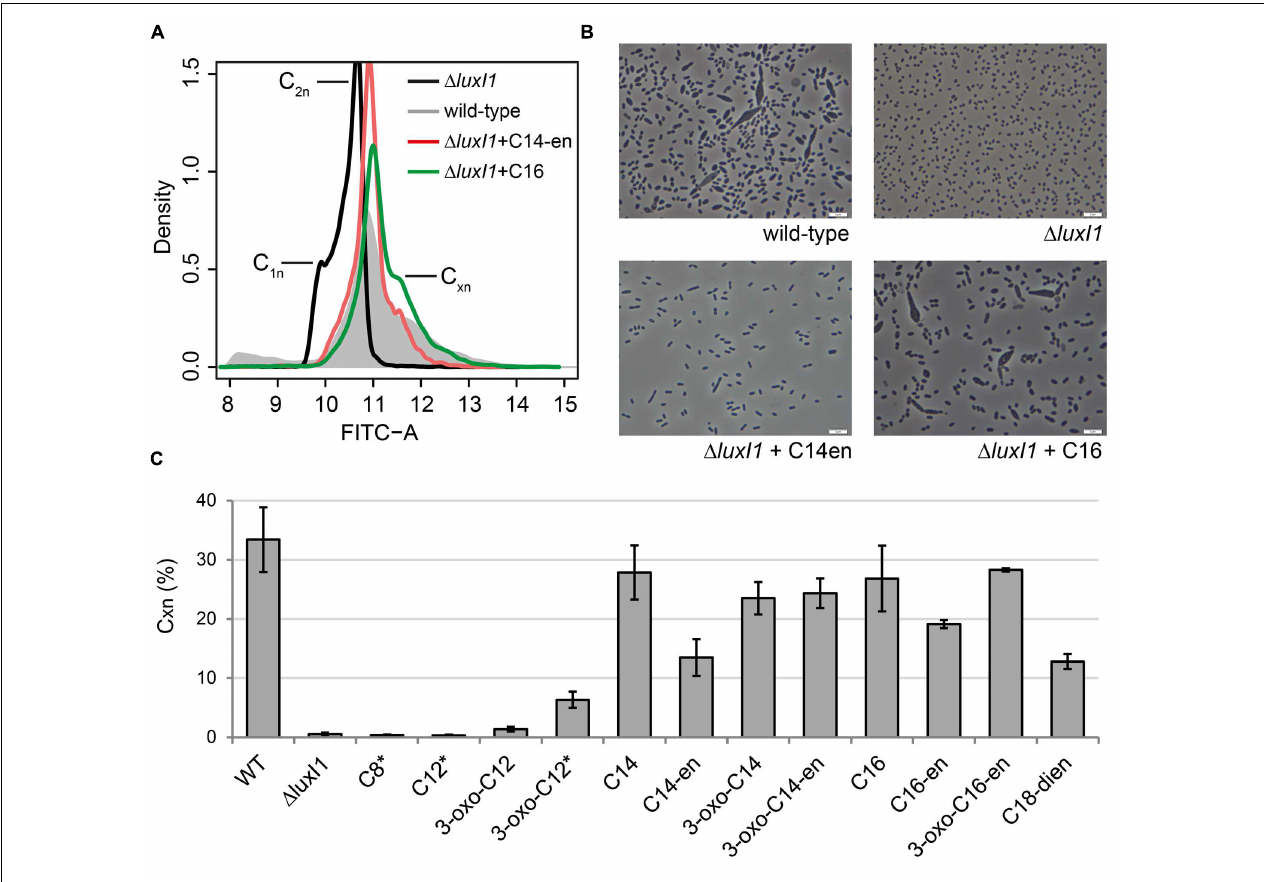
FIGURE 4 | Flow cytometric and microscopic analysis of the QS null mutant D. shibae (cid:49) luxI 1 cultivated with externally added AHLs. (A) Distribution of chromosome equivalents in the wild-type culture (gray), (cid:49) luxI 1 (black), (cid:49) luxI 1 provided with C14en (red), and (cid:49) luxI 1 provided with C16-HSL (green). (B) Microscopic pictures of wild-type, (cid:49) luxI 1 and (cid:49) luxI 1 supplemented with C14en-HSL and C16-HSL. (C) Determination of the fraction of cells containing multiple chromosome equivalents per cell (C xn ) at mid-exponential growth in cultures with the indicated AHLs [added at a concentration of 0.5 µ M; asterisk ( ∗ ) indicates a concentration of 2.5 µ